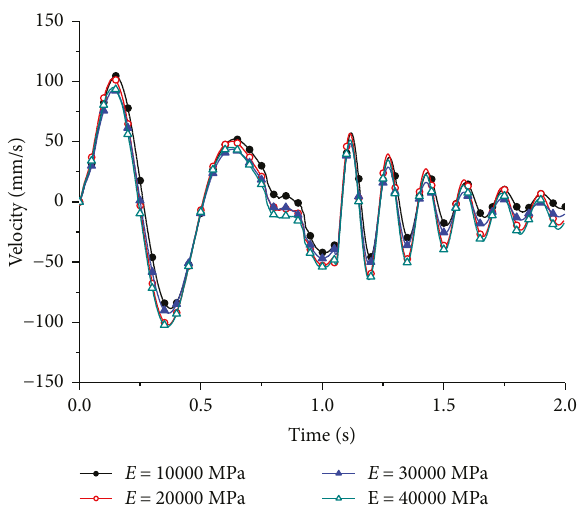
Figure 27: Longitudinal velocity of launch canister top at di ff erent elastic modulus.